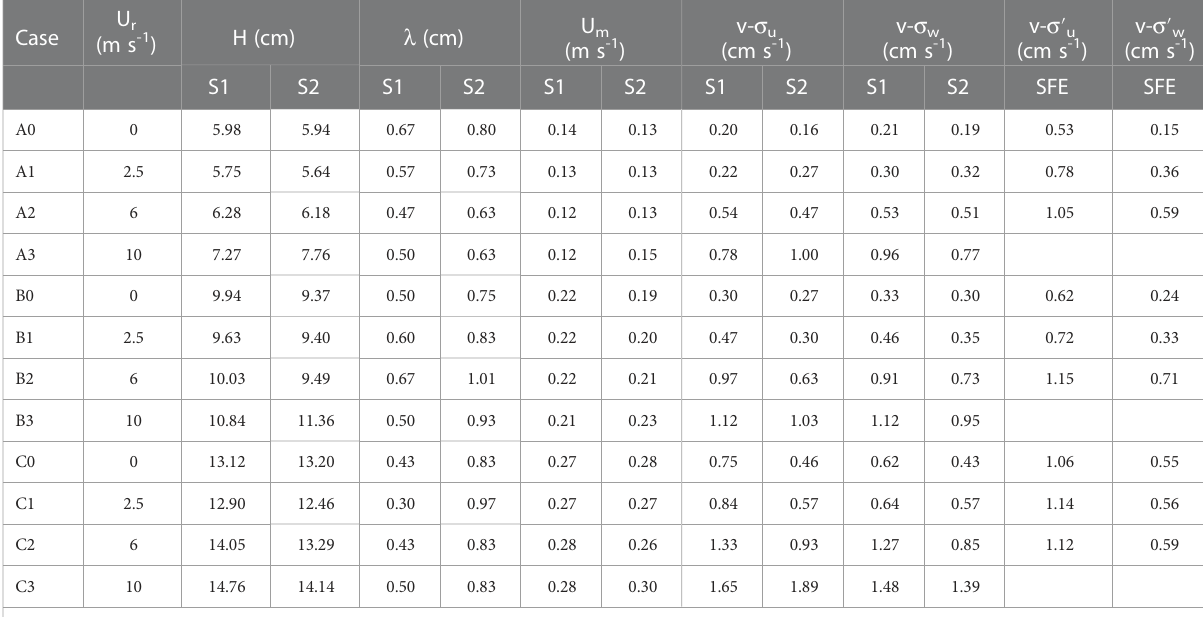
TABLE 1 Basic measurements and derived data for S1 and